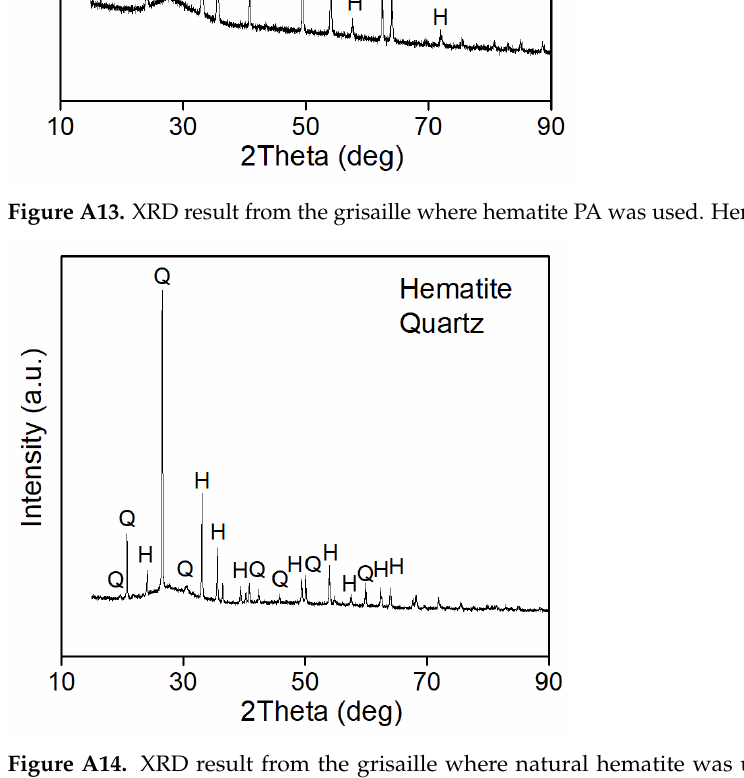
Figure A14. XRD result from the grisaille where natural hematite was used. Hematite (H) and quartz (Q) were identified.